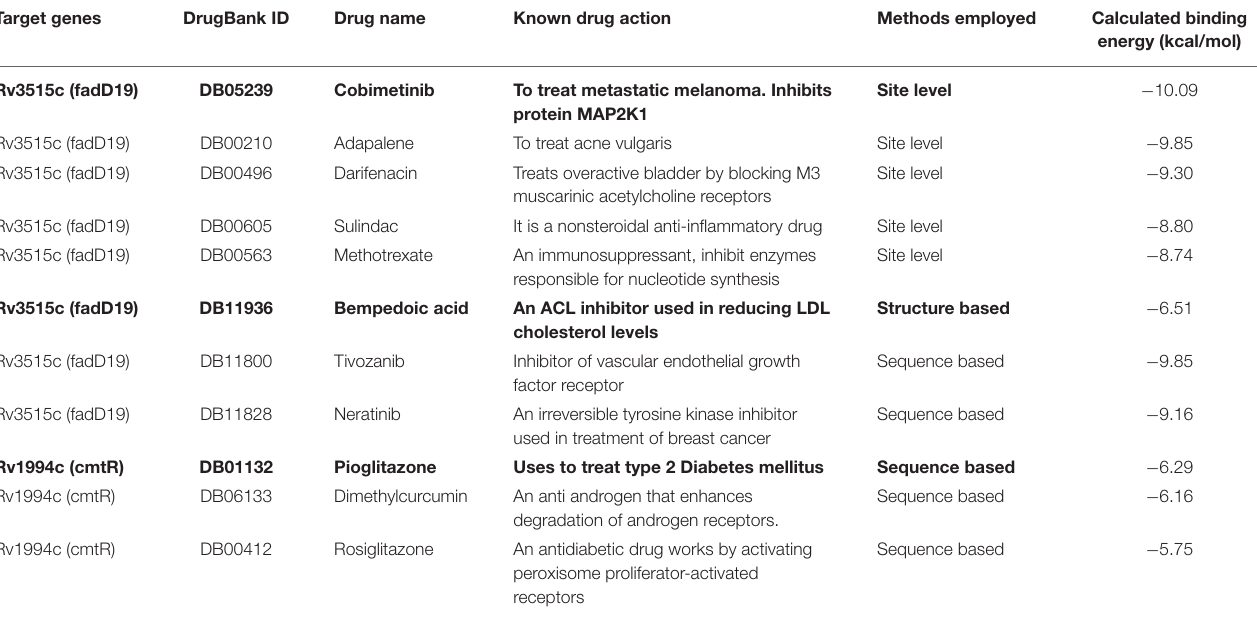
TABLE 4 | A list of top drug hits identified from three distinct methods. Target